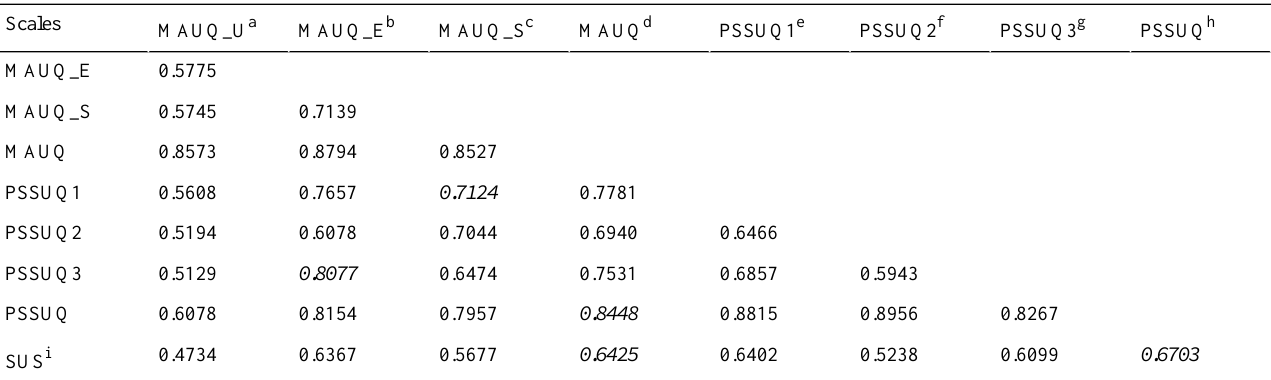
Table 3. Correlation coefficients among scores from the mHealth App Usability Questionnaire, Post-Study System Usability Questionnaire, System Usability Scale, and their subscales. Italics indicate strong correlations among the scales and their